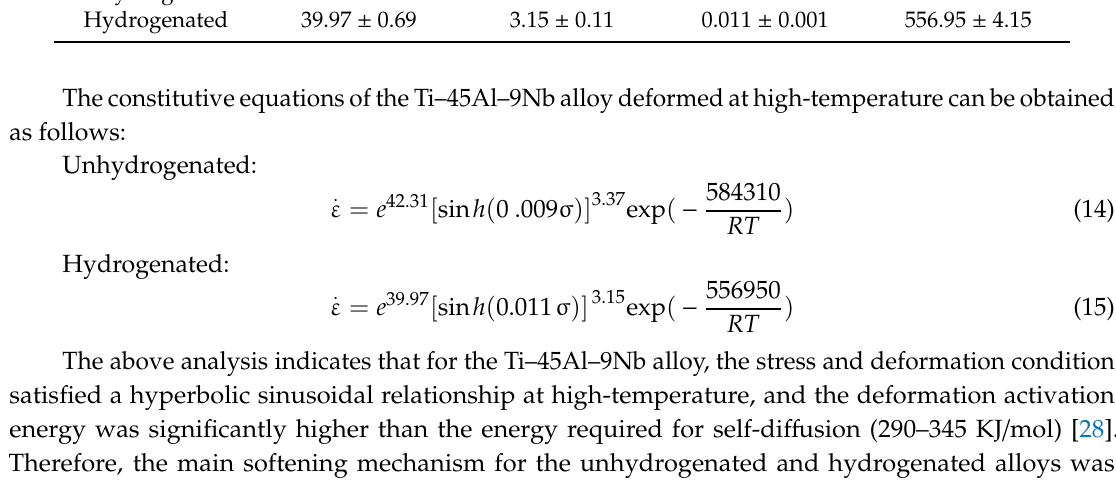
Table 1. Constitutive equation parameter values of the hydrogenated and unhydrogenated alloys. Samples ln A Unhydrogenated 42.31 ±